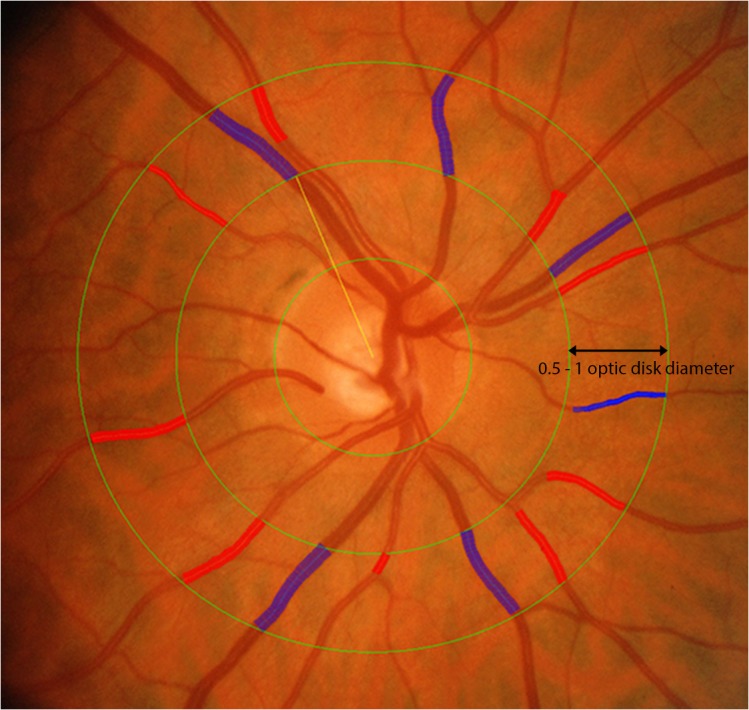
Retinal vascular calibre measurement.Retinal arteriolar and venular calibers were summarized as central retinal arteriolar (CRAE) and the central retinal venular (CRVE) equivalent respectively from digital retinal fundus images using the Interactive Vessel Analysis software (IVAN, University of Wisconsin, US). Arterioles are in red and venules are in blue.